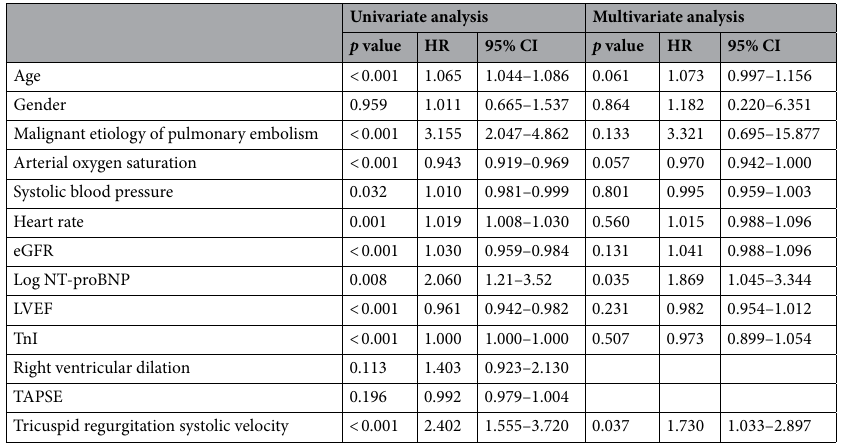
Table 3. Cox proportional hazard uni- and multivariate predictors of long-term mortality. Abbreviations: CI—confidence interval, HR—hazard ratio, eGFR—estimated glomerular filtration rate, LVEF—left ventricular ejection fraction, NT-proBNP—N-terminal pro-brain natriuretic peptide, TAPSE—tricuspid annular plane systolic excursion, TnI—troponin I.